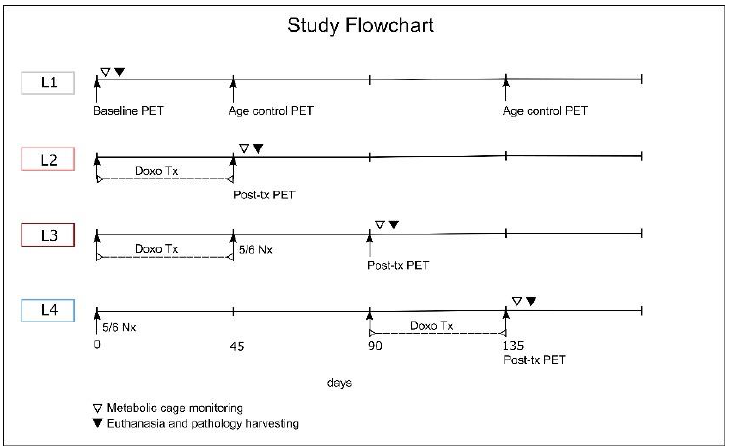
Figure 12. Study flow diagram for the interventions and examinations for each group under study in time.